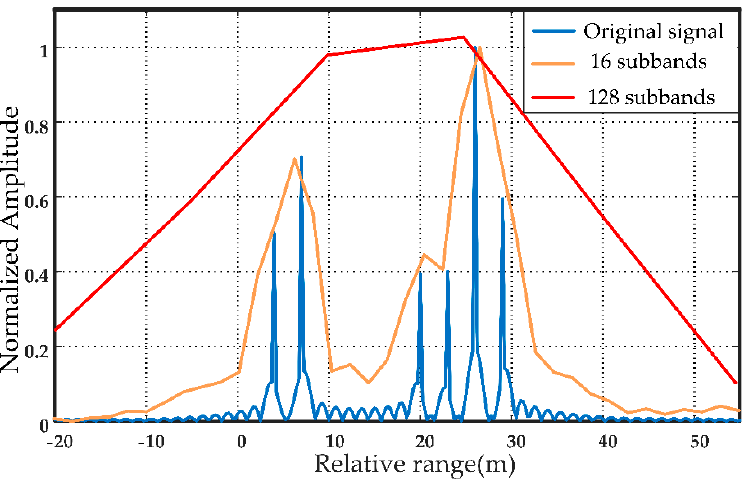
Figure 3. ( a ) Frequency response of prototype filter; ( b ) Frequency response of the filter bank.